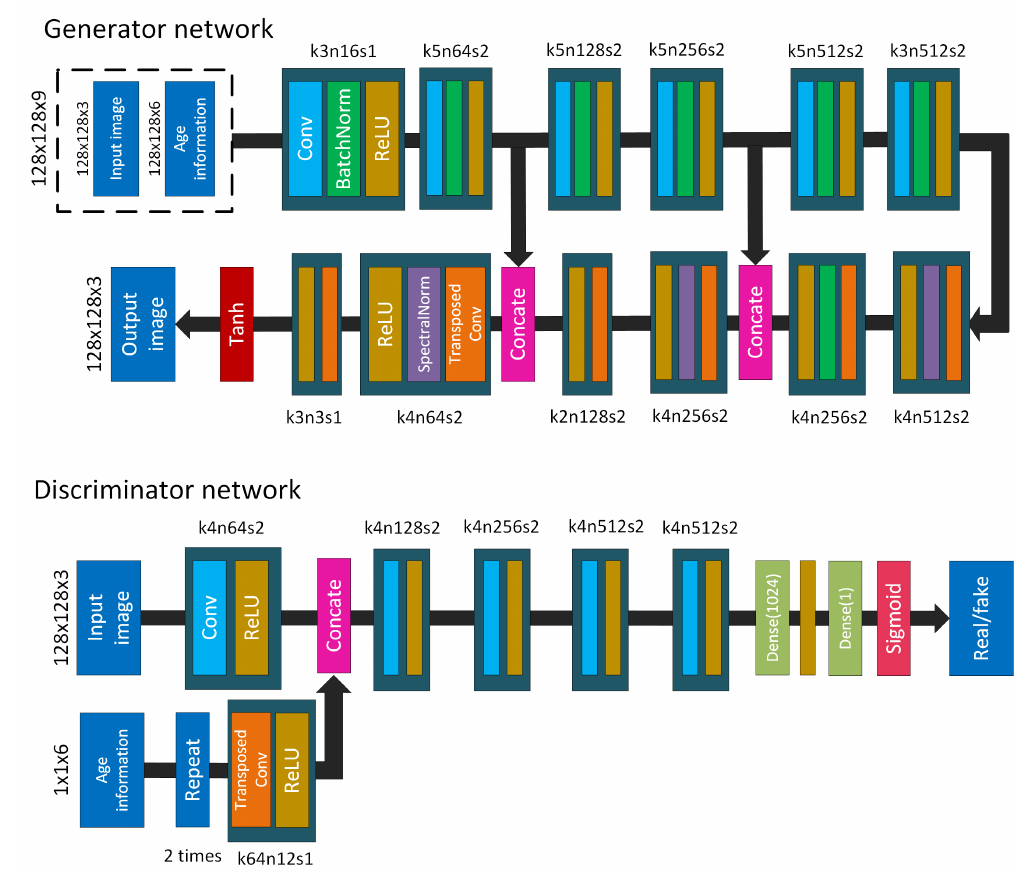
Figure 4. The architecture of the FaceGAN generator and discriminator where k is the kernel size, n is the number of channels and s is the stride for each convolutional